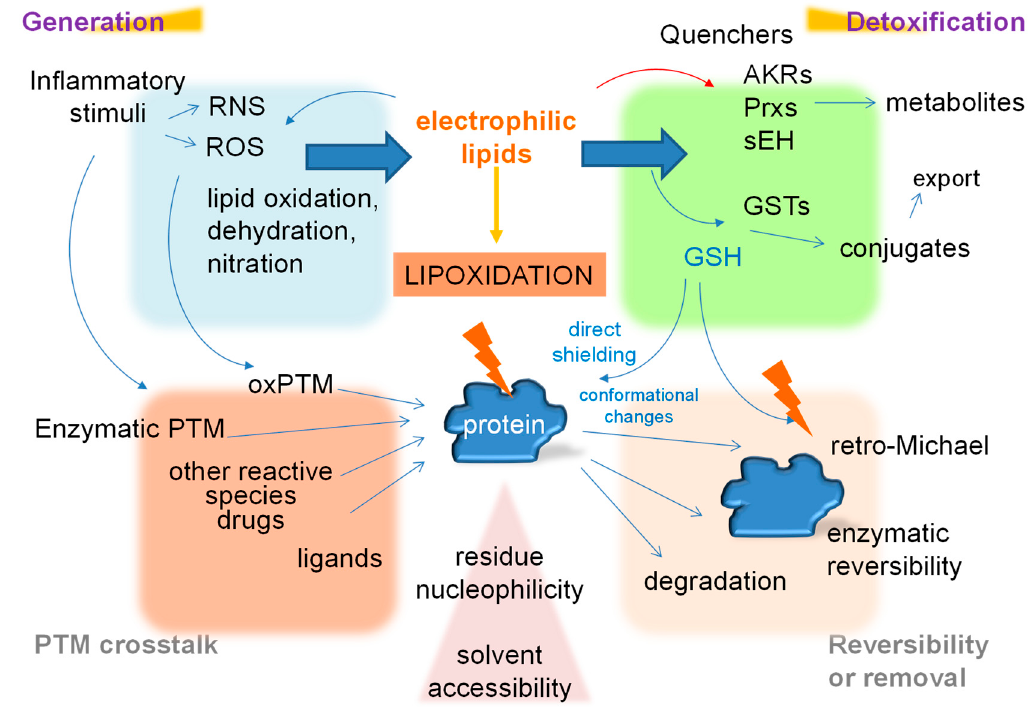
Figure 3. Scheme showing the main factors affecting lipoxidation, from the generation of reactive species and PTM crosstalk on the left to mechanisms of detoxification and reversibility on the right. Please, see text for details and abbreviations.